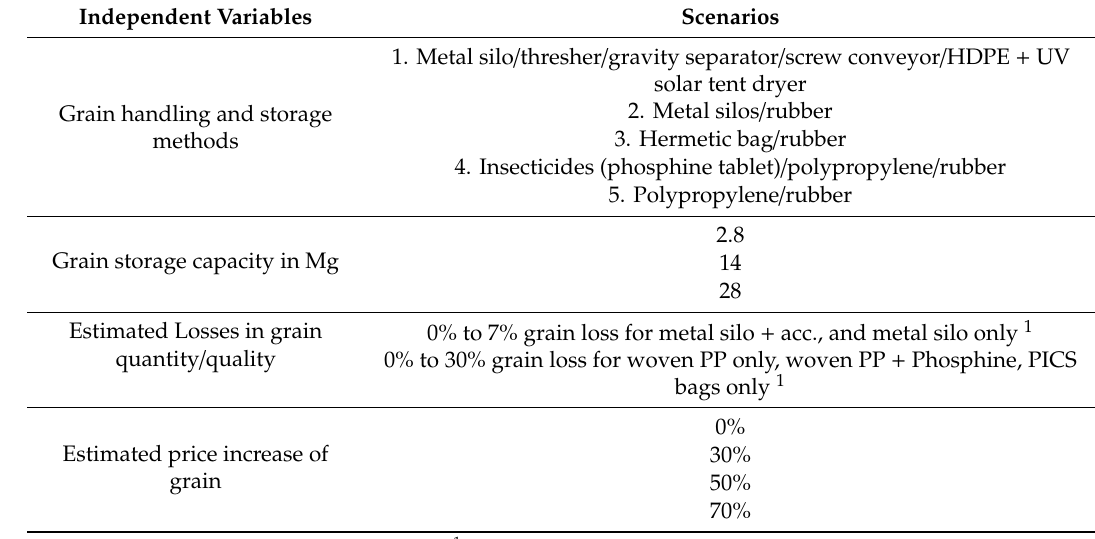
Table 1. Experimental design and parameters used for cost